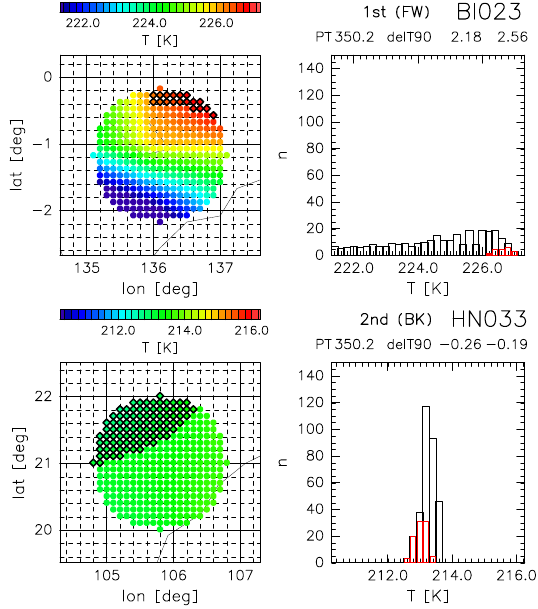
Fig. A2. As for Fig. A1 but for the preliminary match at Biak (top: 22:50UT, 18 January 2006) and Hanoi (bottom: 06:57UT, 21 Jan- uary 2006) on the 350.2K potential temperature